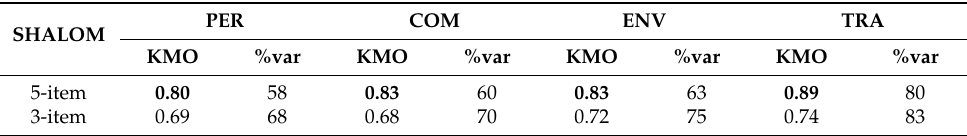
Table 3. Sampling adequacy for 5- and 3-item versions of